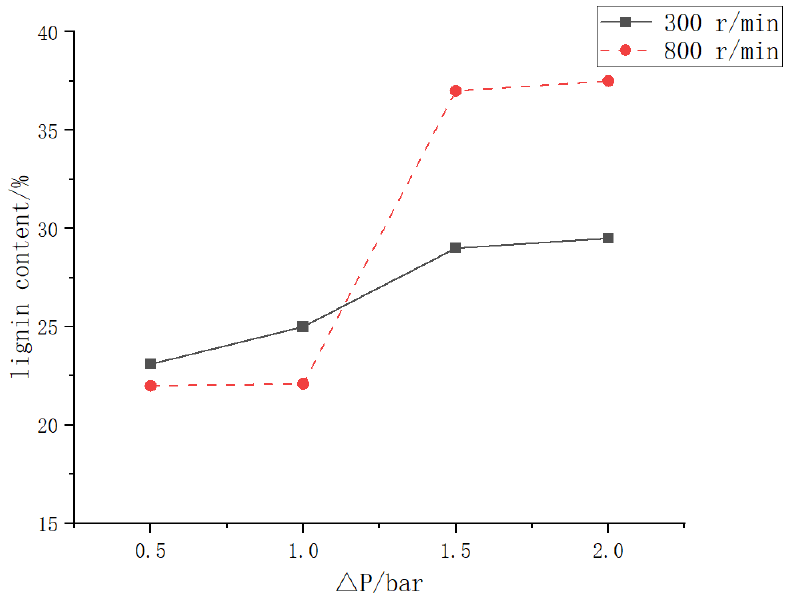
Figure 15. Changes in lignin content in black liquor filtered with vane stirring at 300 and 800 r/min.